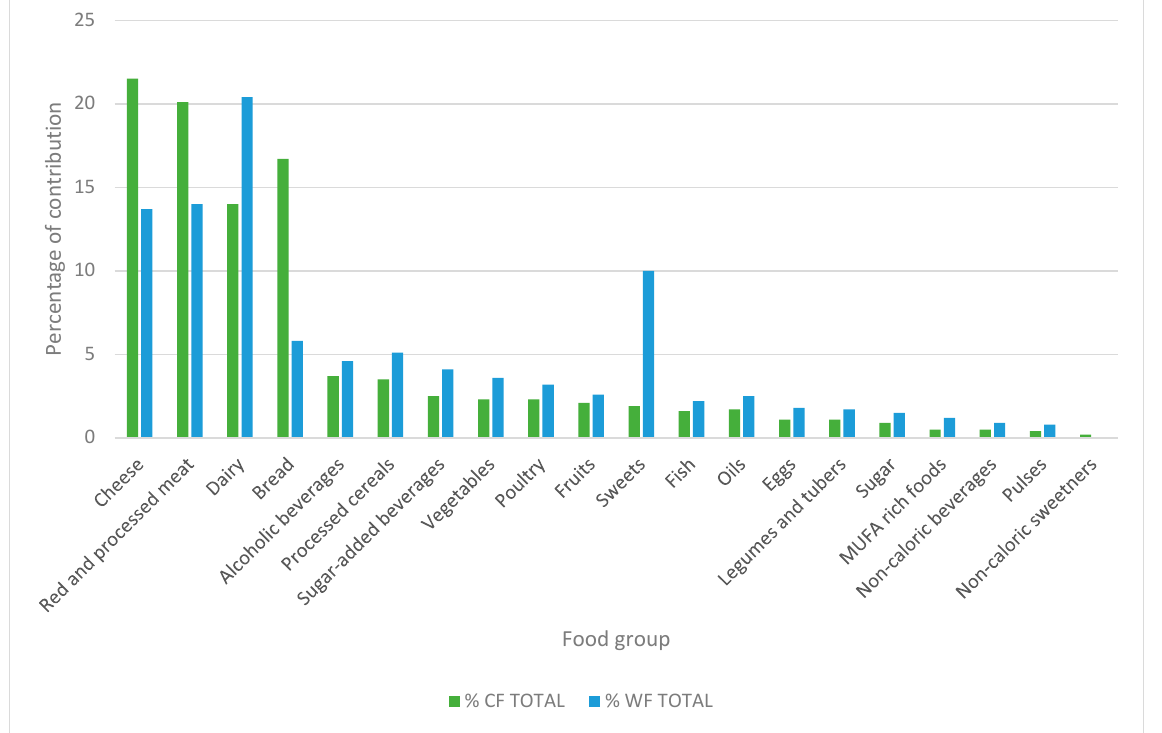
Figure 1. Percentage of contribution of food subgroups to the total carbon and water footprint of the Chilean diet for the general population. The main contributors are cheese (21.5% CF, 13.7% WF), red and processed meat (20.1% CF, 14% WF), dairy (14% CF, 20.4% WF), bread (16.7% CF, 5.8% WF), and “sweets” (originally in the survey as sugar from sweets and other sweet food) (1.9 CF%, 10% WF).